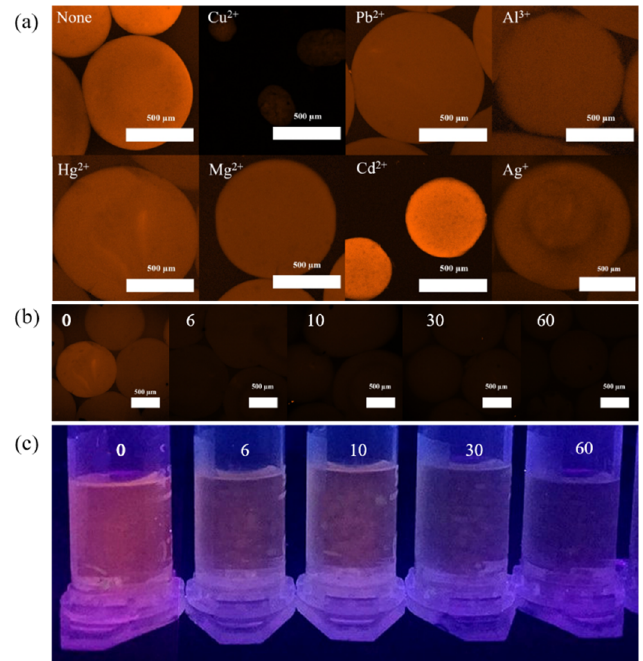
Figure 15. CLSM of CMC−GE−AQ microspheres with ( a ) several typical metal ions (10 −4 mol L −1 ) and ( b ) different concentrations of Cu 2+ (0, 6, 10, 30 and 60 × 10 −6 mol L −1 ); ( c ) fluorescent photographs of CMC−GE−AQ suspension with different concentrations (0, 6, 10, 30 and 60 × 10 −6 mol L −1 ) under 365 nm UV lamp. (CMC−GE−AQ: 1.5 × 10 −4 g mL −1 ; solvents: DMF/H 2 O solution ( v / v = 8/2, pH = 7); excitation wavelength: 425 nm; excitation slit: 5